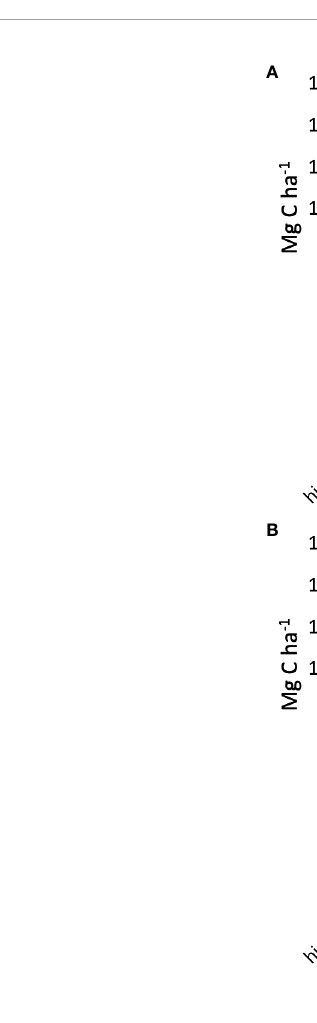
FIGURE 5 | Calculated means of soil organic carbon (SOC) stocks (Mg C ha -1 ) for depth intervals <=30 cm for grasslands and rangelands in sub-Saharan Africa compared to IPCC default reference condition SOC stocks to 30 cm for different climates and soil types. Bars show SOC stocks in (A) tropical dry climates (<1000 mm yr -1 ) and (B) tropical wet climates (1000 – 2000 mm yr -1 ) for high activity clay, low activity clay, sandy, and volcanic soils. Error bars correspond ± 95% CI for reported observations, whereas error bars for IPCC 2019 defaults express uncertainty as percentage of the mean. n = number of observations used for mean ± 95% CI